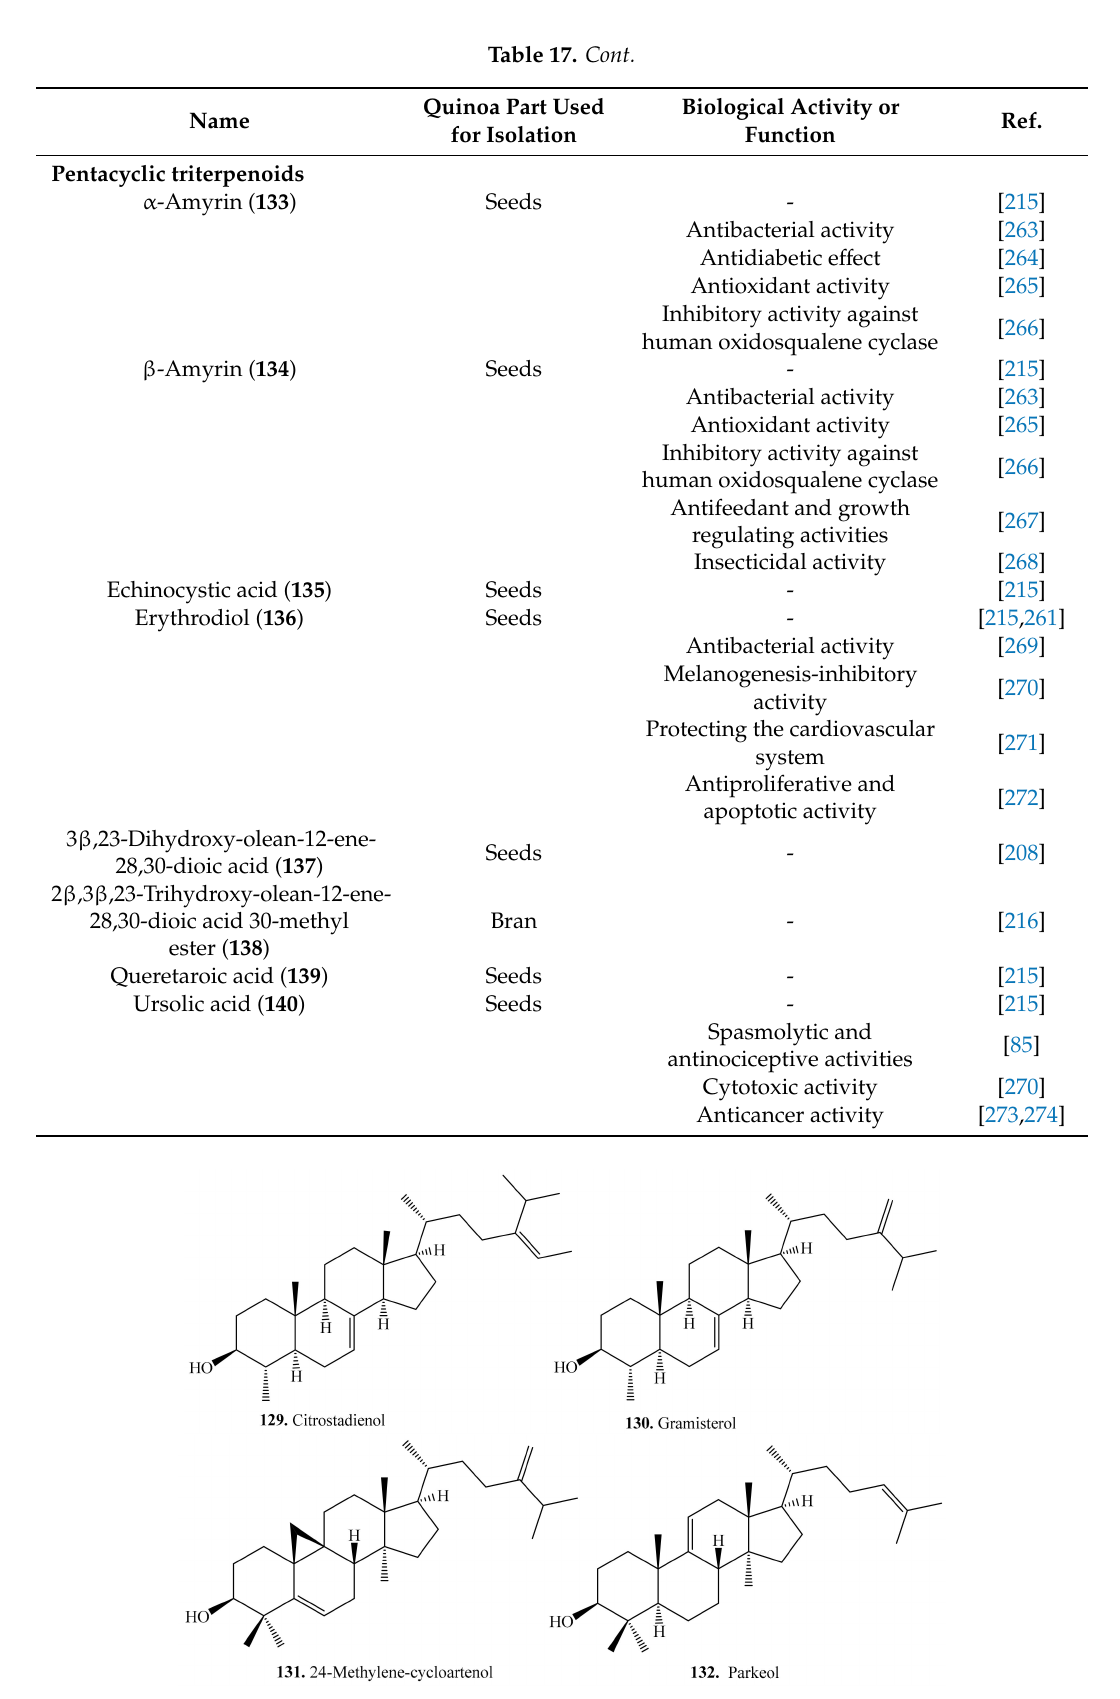
Figure 19. Structures of the tetracyclic triterpenoids isolated from